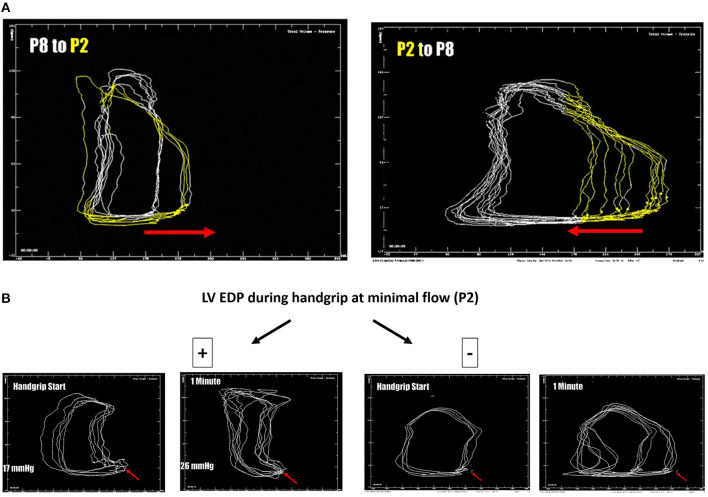
(A) LV pressure-volume loops (original tracings) from patients during Impella-rate reduction (P2, marked in yellow, on the left) as well as back to maximal unloading (P8, on the right). The typical shift on the xy plan is observed. (B) LV pressure-volume loops (original tracings) from patients during handgrip. On the right a patient who profited from unloading, showing no or minimal increase of LV end-diastolic pressure (EDP, red arrow) during handgrip; on the left a patient who had an abnormal pronounced increase of LV EDP during handgrip, as a sign of blunted contractile reserve.